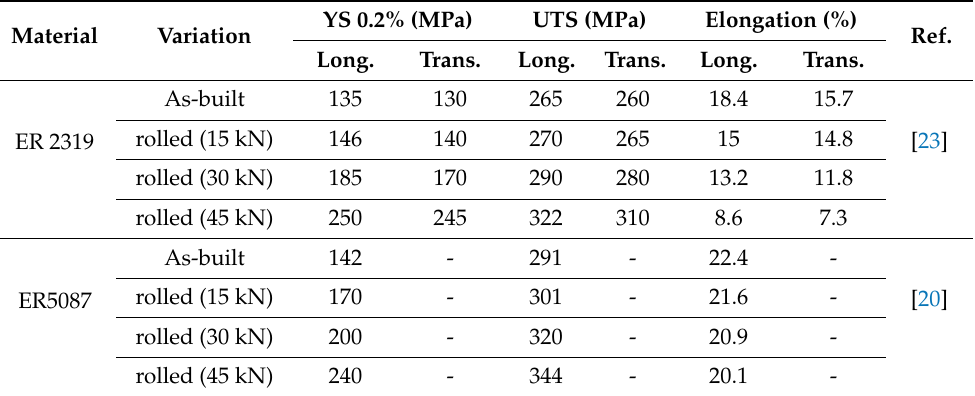
Table 3. Mechanical properties of different aluminum alloys with different build conditions in the longitudinal (Long.) and transversal (Trans.) directions.